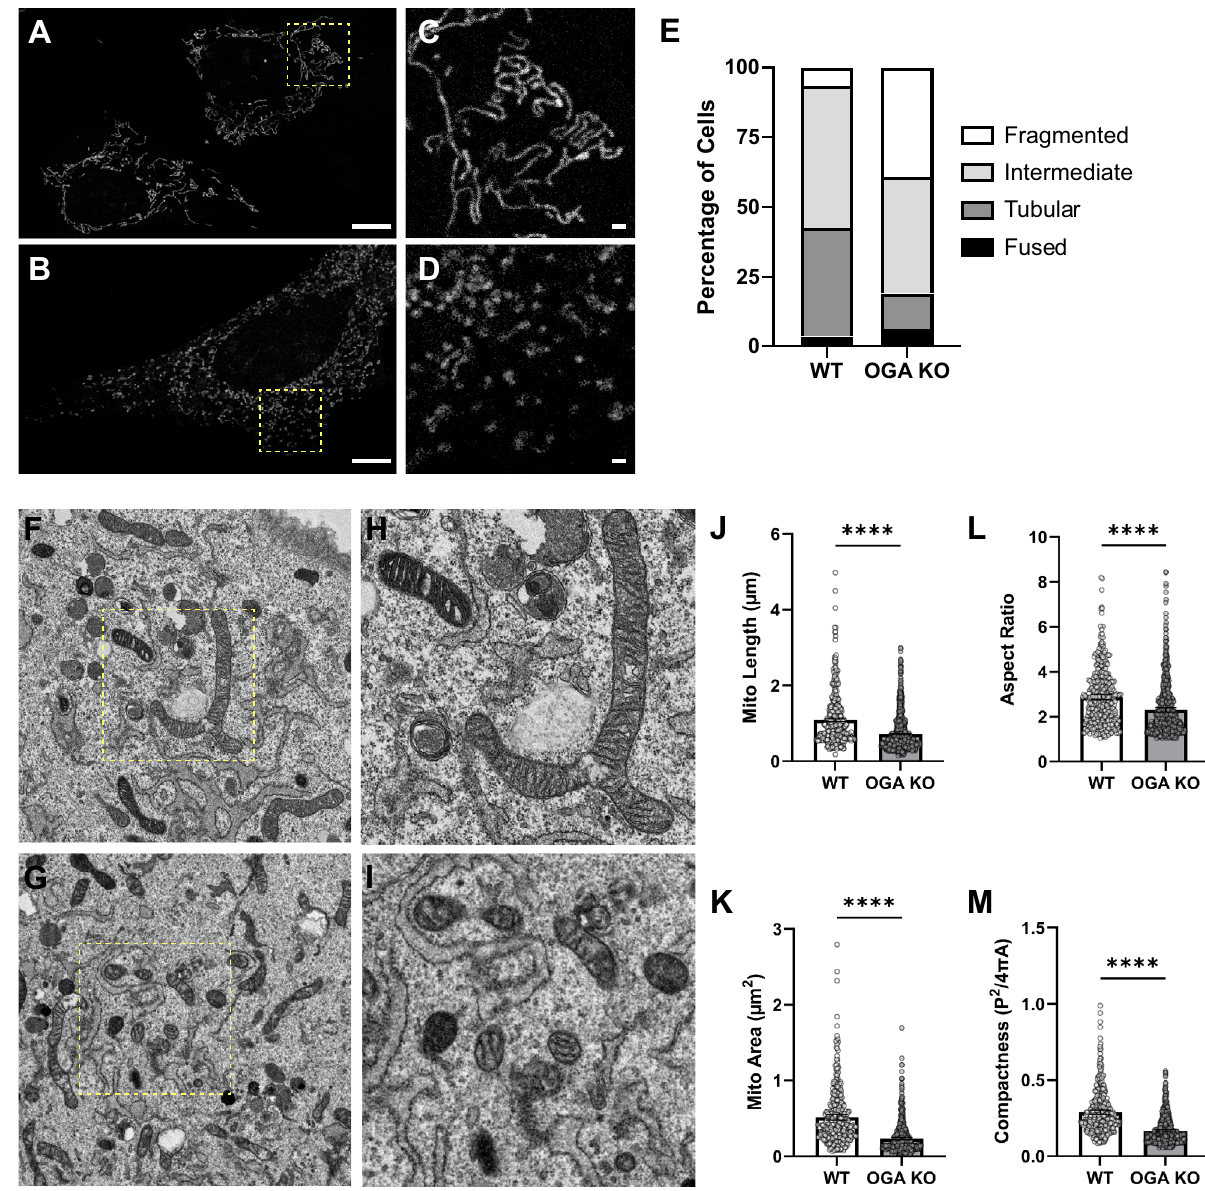
Figure 1. Mitochondrial Fission is Enhanced in OGA KO MEFs. ( A–D ) Confocal microscopy images with Mitotracker dye are presented for WT ( A ) and OGA KO ( B ) MEFs; Scale bars, 10 µm. Select areas (highlighted with a yellow dashed box) are enlarged for WT ( C ) and OGA KO ( D ) MEFs; Scale bars, 1 µm. ( E ) The quantified percentage of cells characterized by mitochondrial morphologies (fused, tubular, intermediate, or fragmented) in basal WT and OGA KO MEFs are shown (WT cells = 108 counted, OGA KO cells = 110 counted). ( F–I ) Representative transmission electron microscopy (TEM) images of fixed sections for WT ( F ) and OGA KO ( G ) MEFs are presented; Scale bar, 2 µm. Enlarged areas of WT ( H ) and OGA KO ( I ) MEFs highlight local mitochondrial morphologies. Quantification of mitochondrial length (J), area (K), aspect ratio (L), and compactness (M) are shown (An unpaired Student’s t test shows ****p < 0.0001; WT mitochondria = 391 counts, OGA KO mitochondria = 616